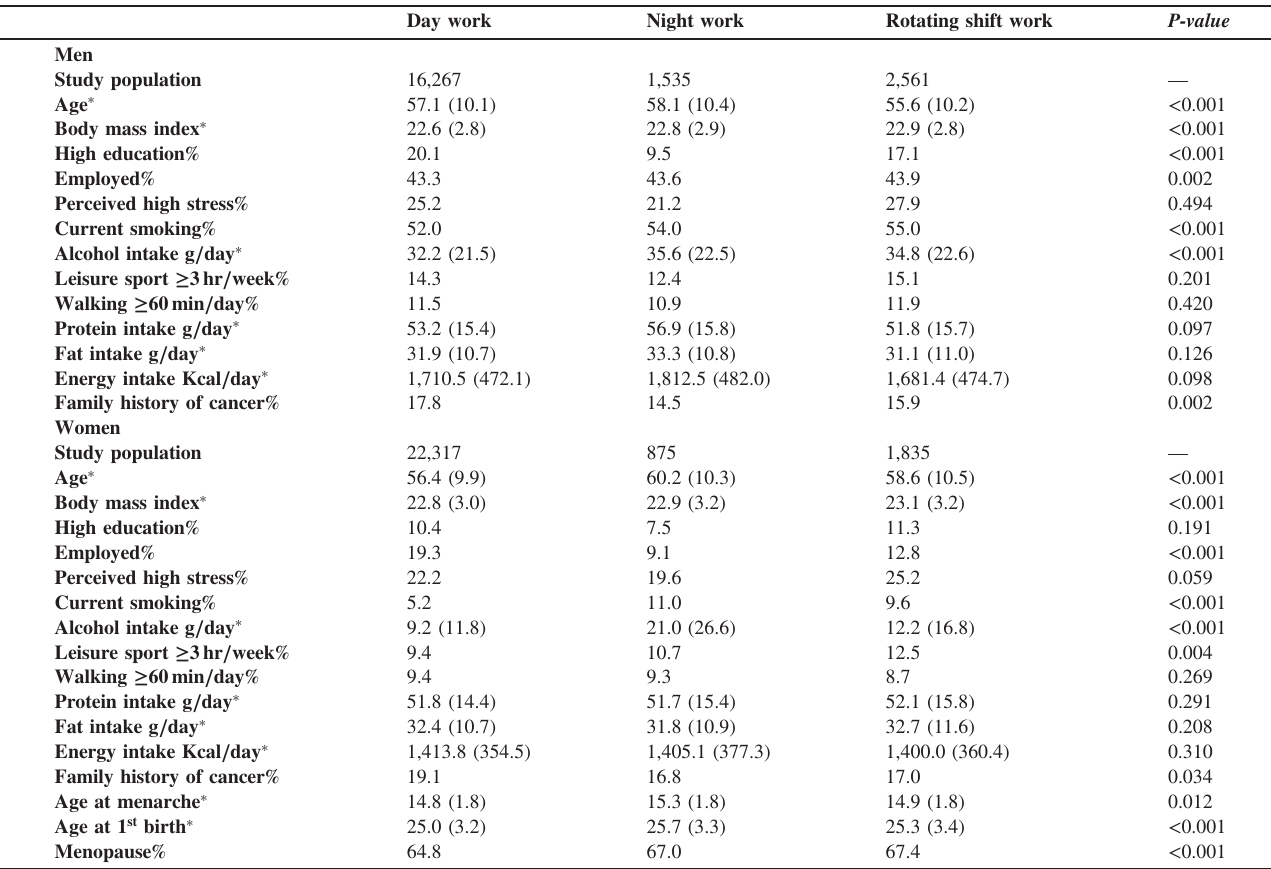
Table 1. Age-adjusted sociodemographic characteristics of Japanese working men and women distributed by their work schedule (JACC Study) Day work Night work Rotating shift